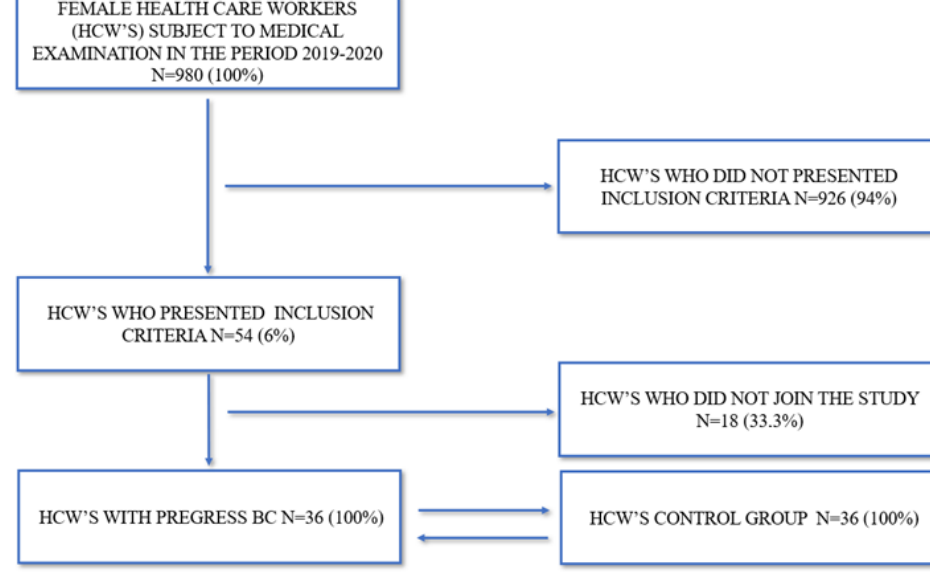
Figure 1. Flow chart of the sample studied.